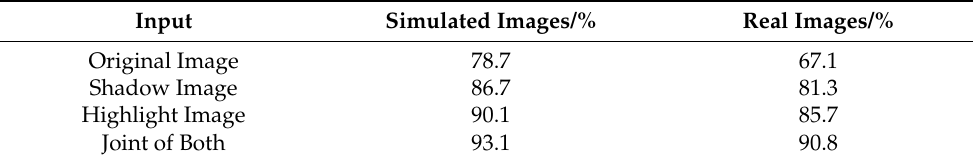
Table 5. Classification accuracy of simulation and real data.